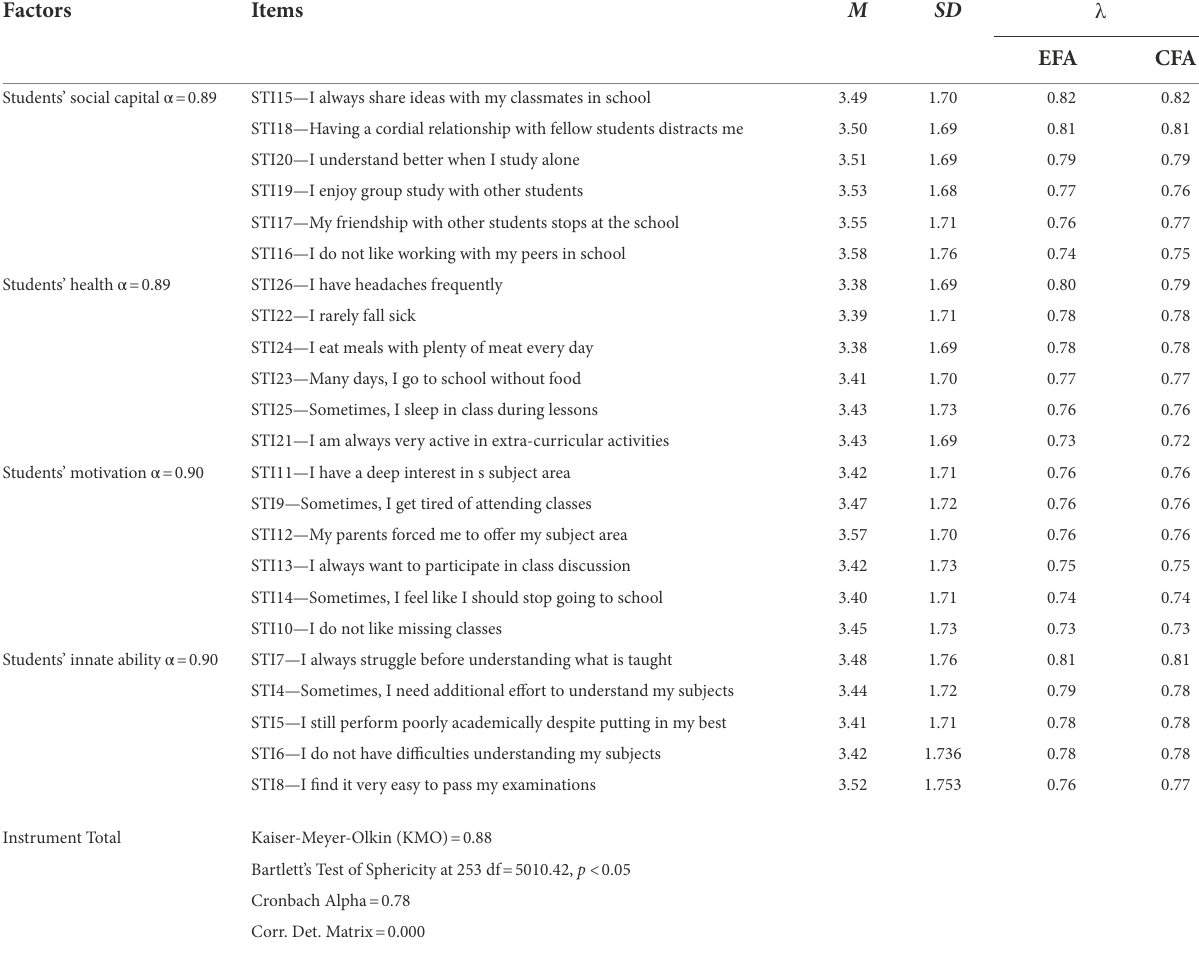
TABLE 1 Exploratory factor analysis of the structure of the